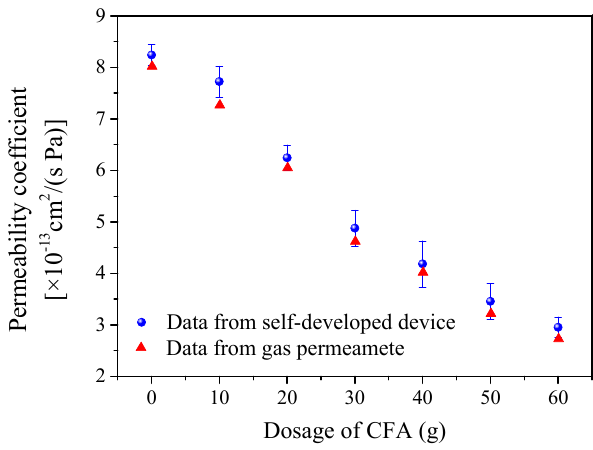
Figure 5. Permeability coefficients of coating specimens No. 19–25 obtained through self ‐ developed device and through gas permeameter.